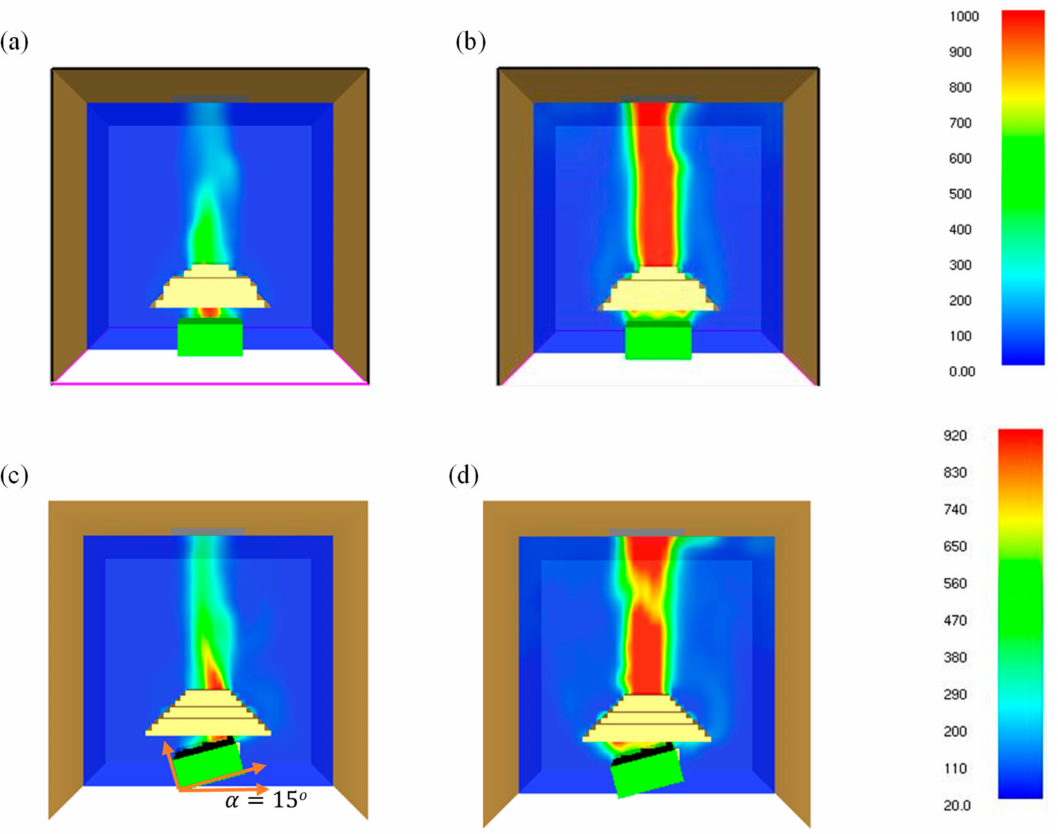
Figure 11. Effect of material orientation on the temperature of the exposed surface at 35 kW/m 2 for ( a ) ignition phase— 0 ◦ samples; ( b ) flashover (PHRR)—0 ◦ samples; ( c ) ignition phase—15 ◦ samples; ( d ) flashover (PHRR)—15 ◦ samples (temperature in colour